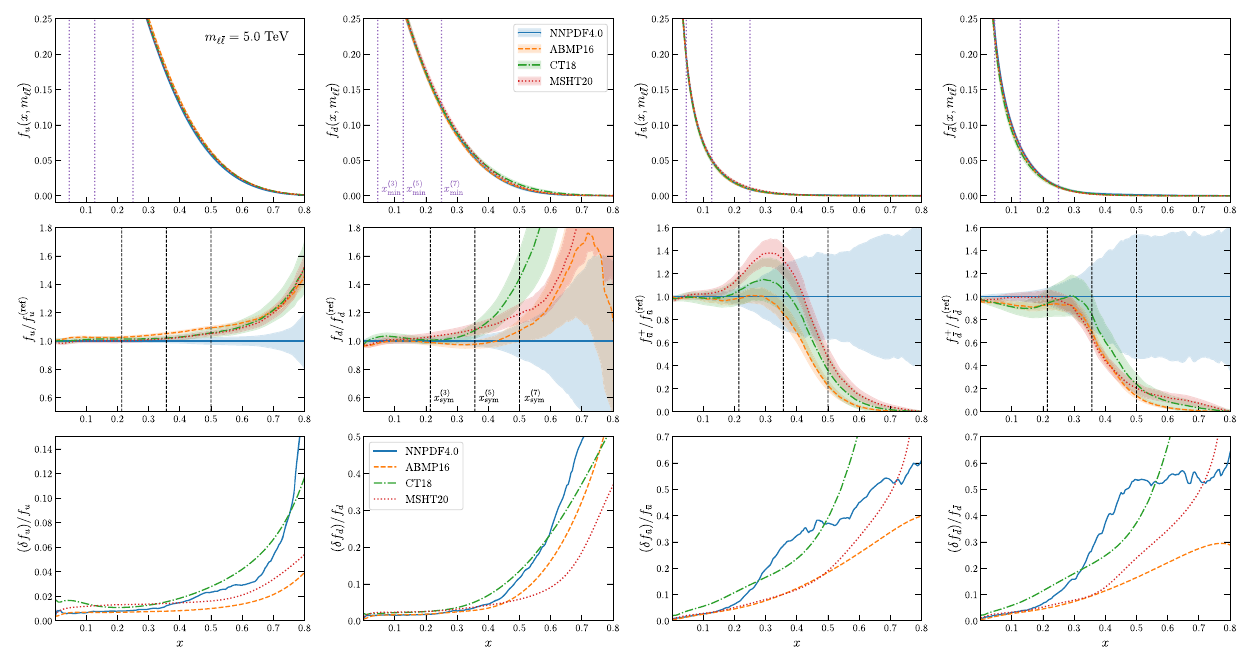
√ s for three different val- and in the central row those of x sym = m (cid:2) ¯ (cid:2) / ues m (cid:2) ¯ (cid:2) = 3 , 5 , 7 TeV. Note that in the second row the range on the y axis is not the same for quarks and antiquarks, and in the third row also for up and down quarks. Note also that the PDFs, their ratios and their uncertainties are essentially unchanged in the displayed large- x region / s in the range 1 TeV < m (cid:2) ¯ (cid:2) < 7 (cid:2) ¯ (cid:2)